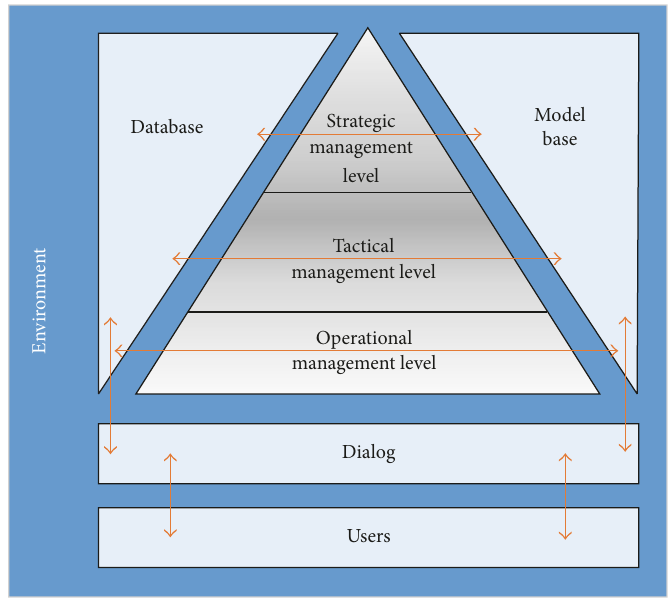
Figure 1: Structure of the decision support system for early warning management